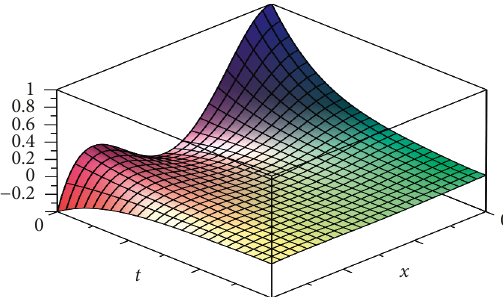
Figure 3: The approximate solution of ζ